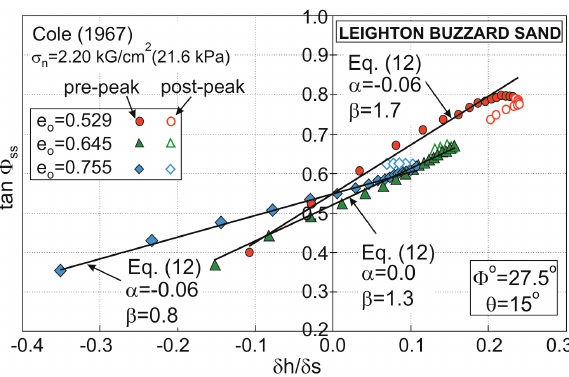
Fig. 5. Influence of the initial porosity on the stress ratio-dilatancy relationship in simple shear